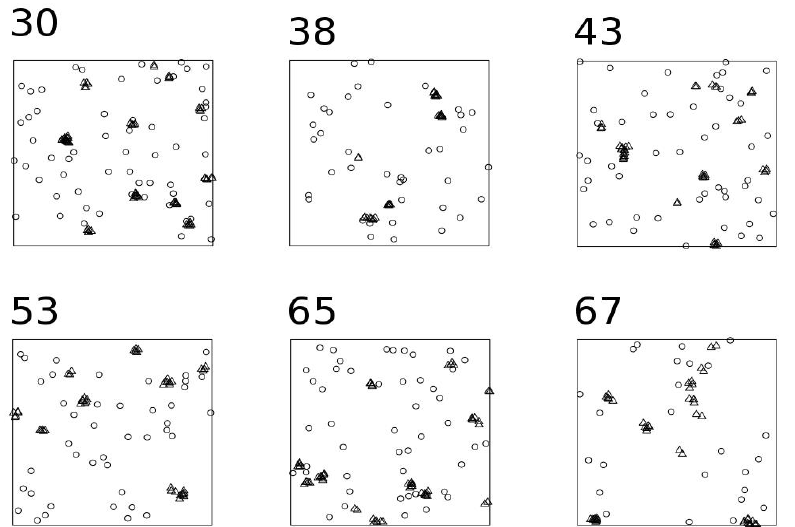
Figure 2. Examples of NNIC using random points. Open circles are non-clustered points; black circles are clustered points. Figure numbers indicate the number of the iteration (see Table S1).